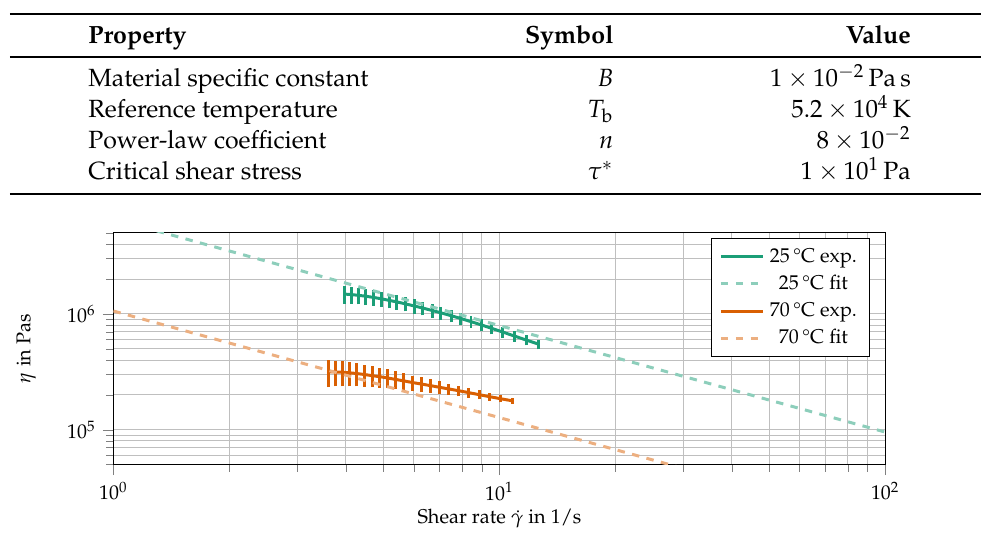
Table A2. M OLDEX 3D and 3D TIMON parameters.